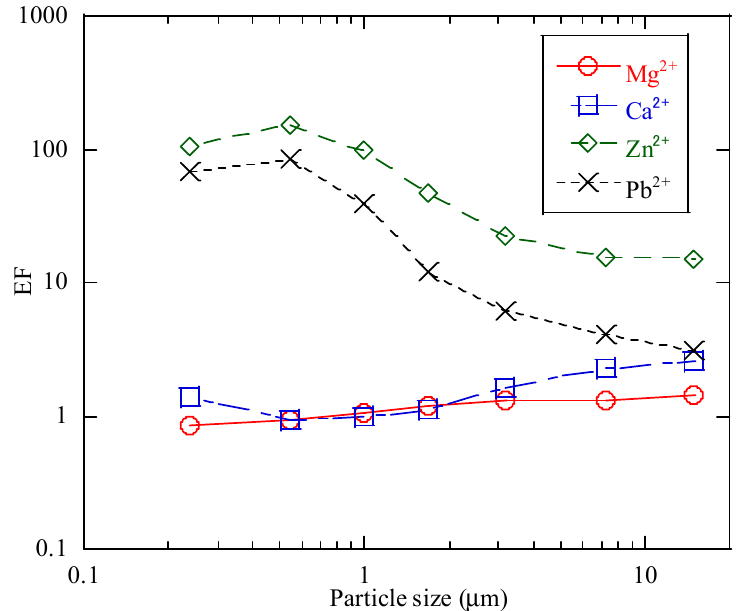
Figure 3. Enrichment factor (EF) relative to crustal abundances for Mg (nss-Mg), Ca, Zn, and Pb in the aerosol samples.